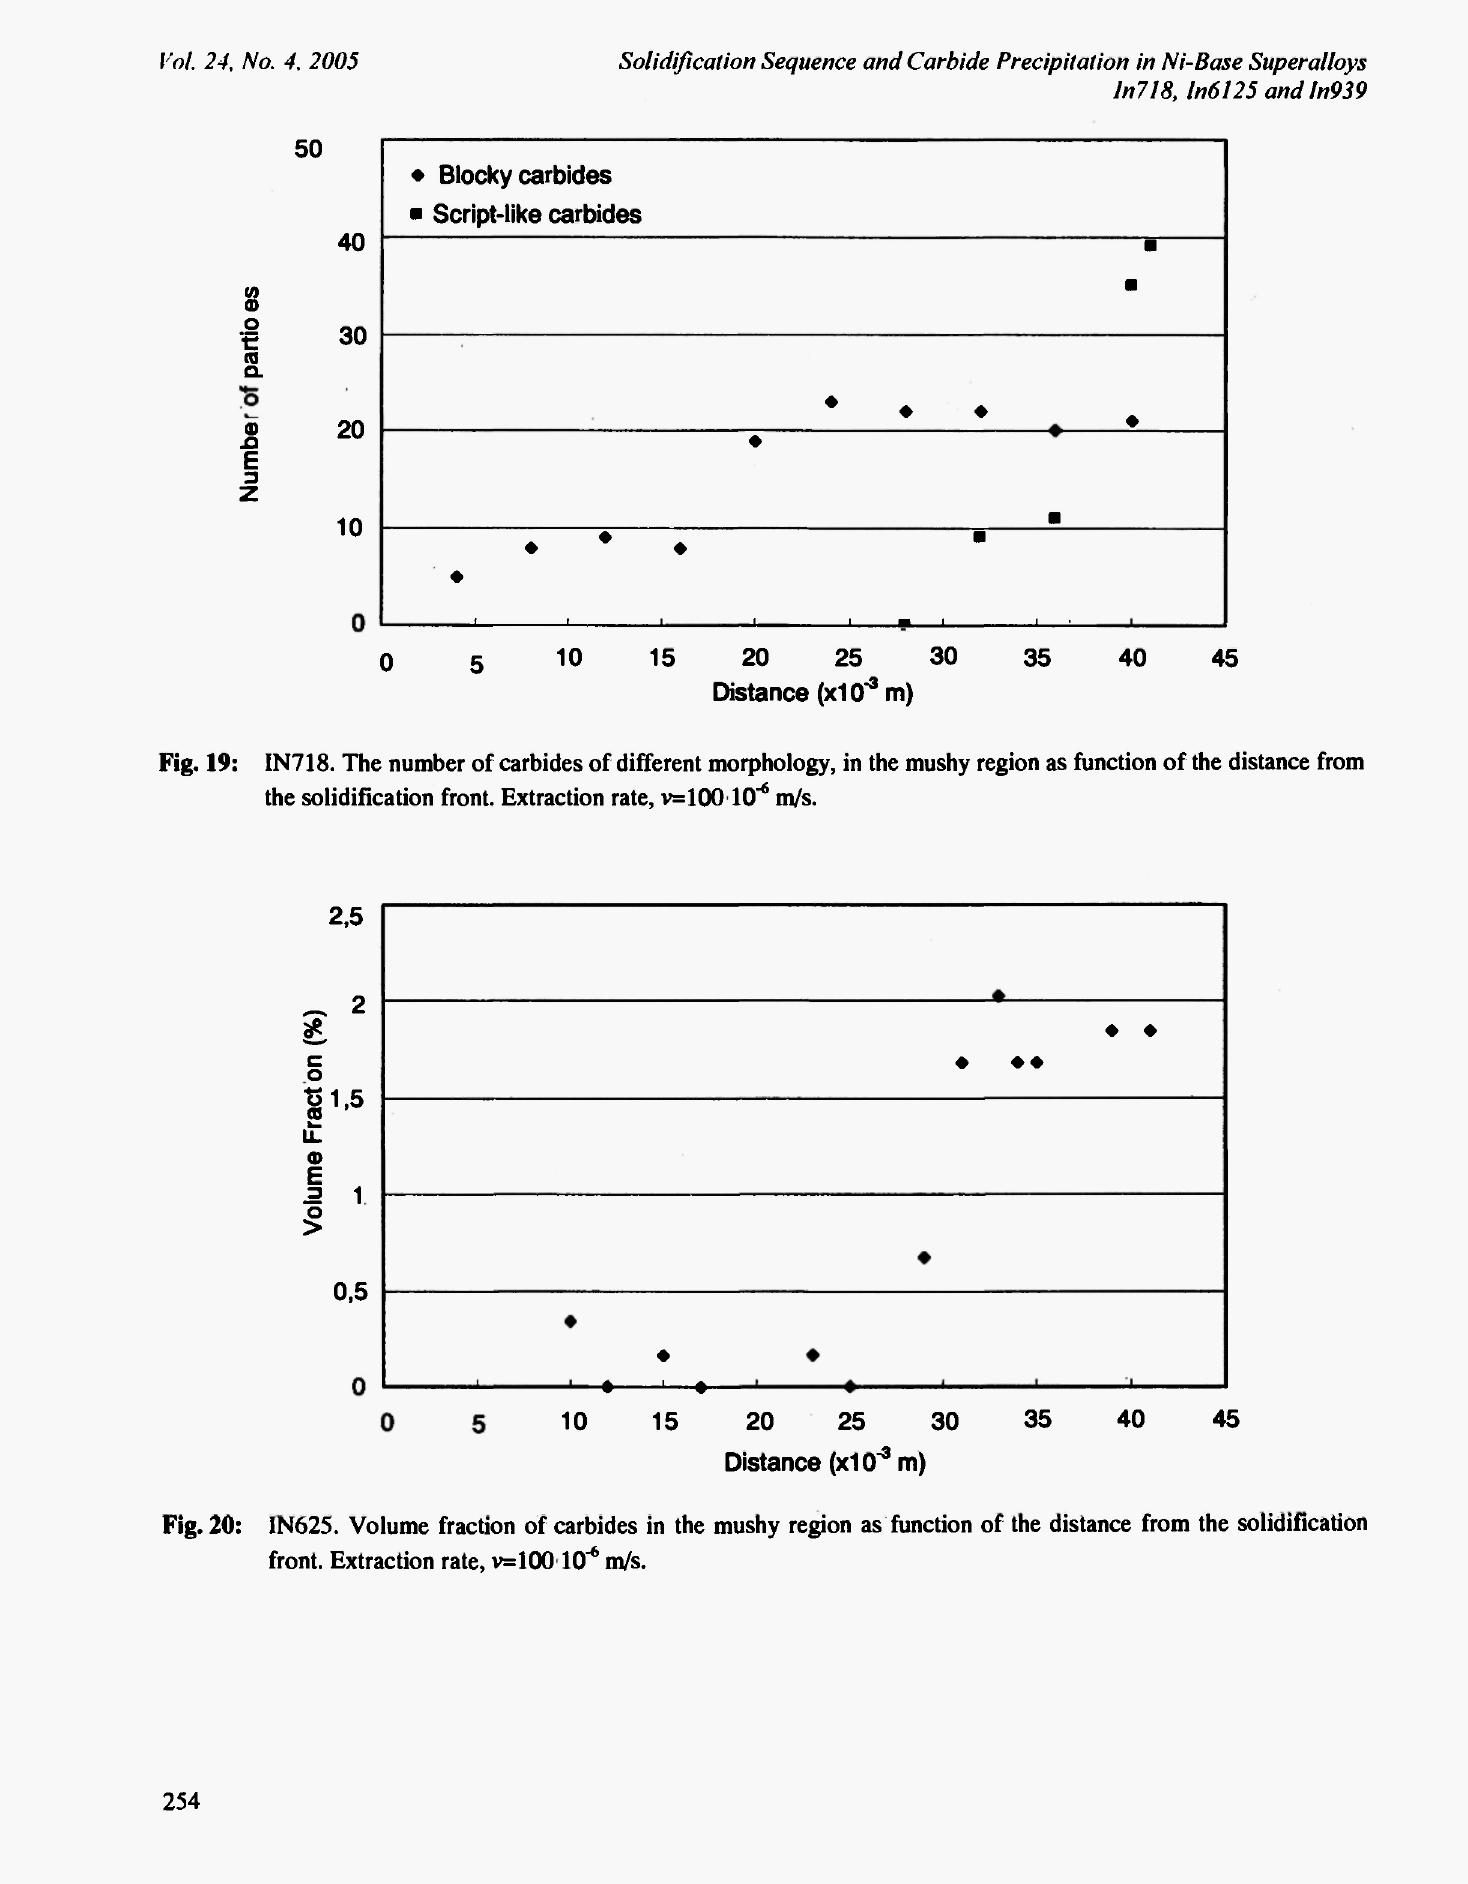
Fig. 20: IN625. Volume fraction of carbides in the mushy region as function of the distance from the solidification front. Extraction rate, v=10010· 6